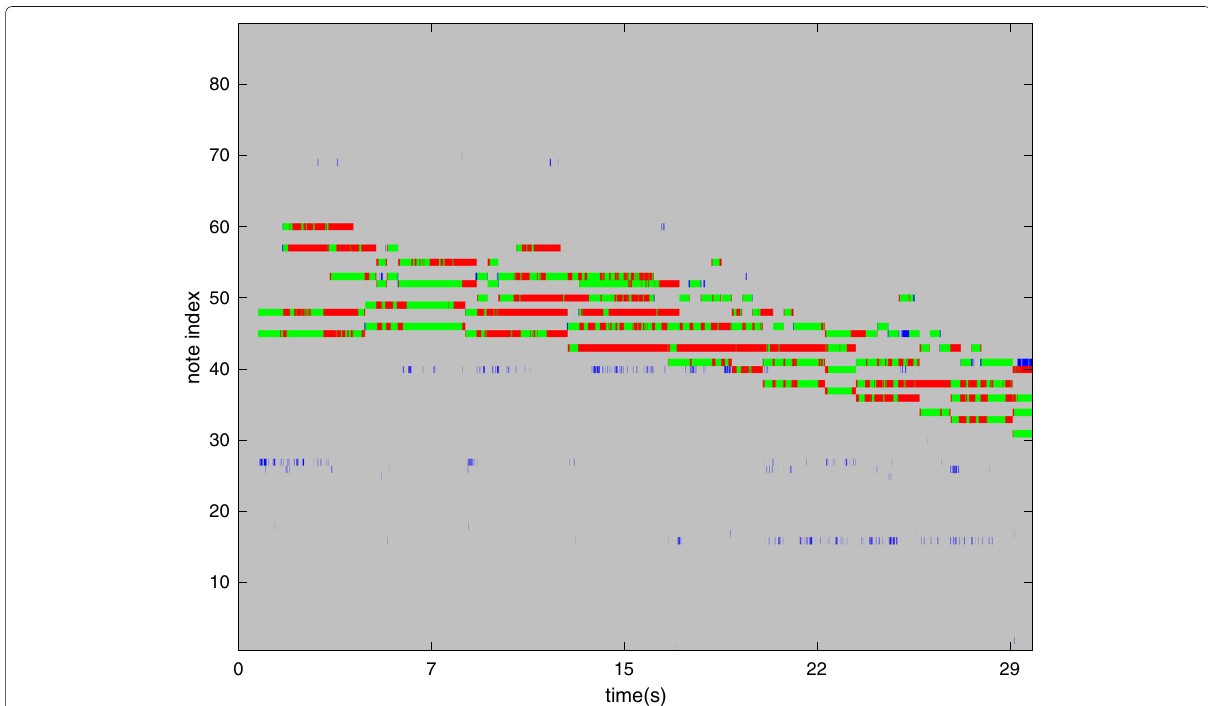
Fig. 15 AMT results of the first 30 s of “MAPS_MUS-deb_clai_ENSTDkCl” produced by plain MPENet, where legends can be referred to Fig. 14. A typical case of false negatives is where notes have long duration (still, MPENet can detect the attack of each note, but decays are discontinuous since the note probabilities are polarized caused by non-linear classifiers, c.f Fig. 7)